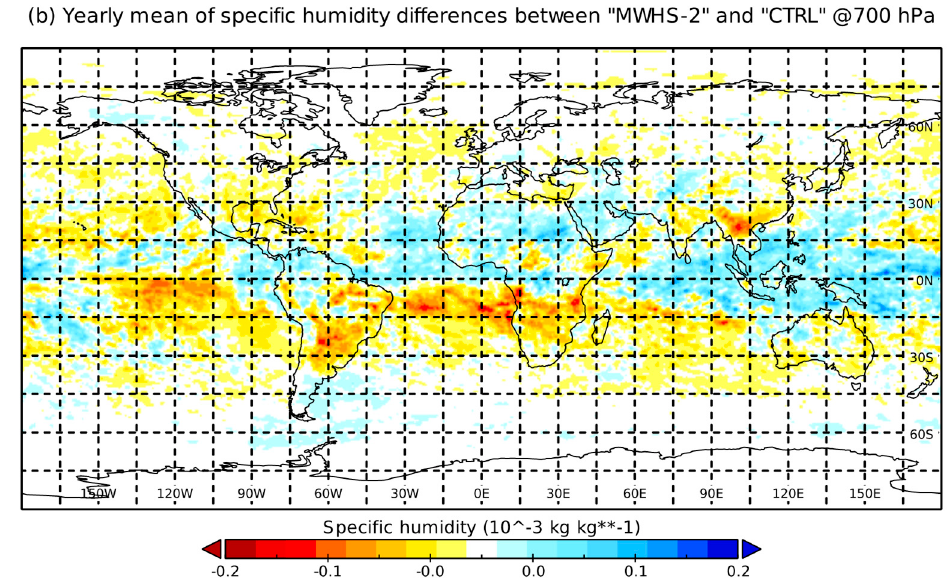
analysis fields in the “MWHS ‐ 2” and “CTRL” experiments at 850 hPa ( a ) and 700 hPa ( b ).